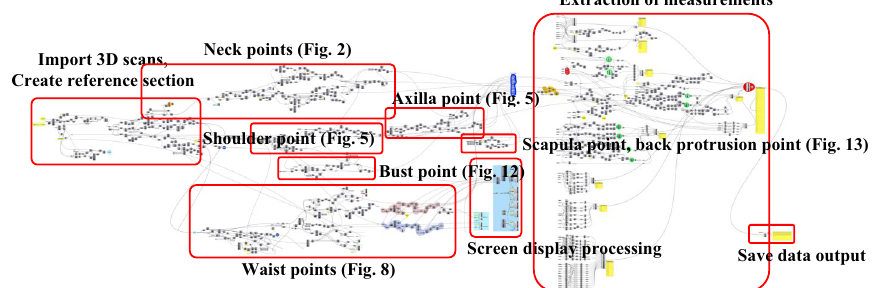
Fig. 14 Algorithm for automatic search for landmarks and extraction of